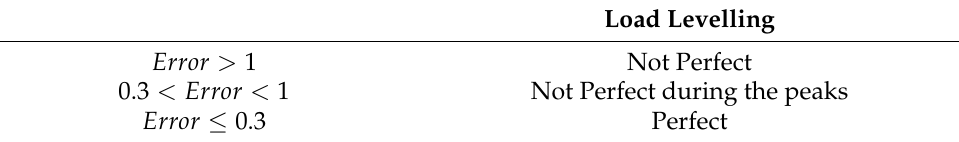
Table 7. Numerical allocation of the load levelling graphical